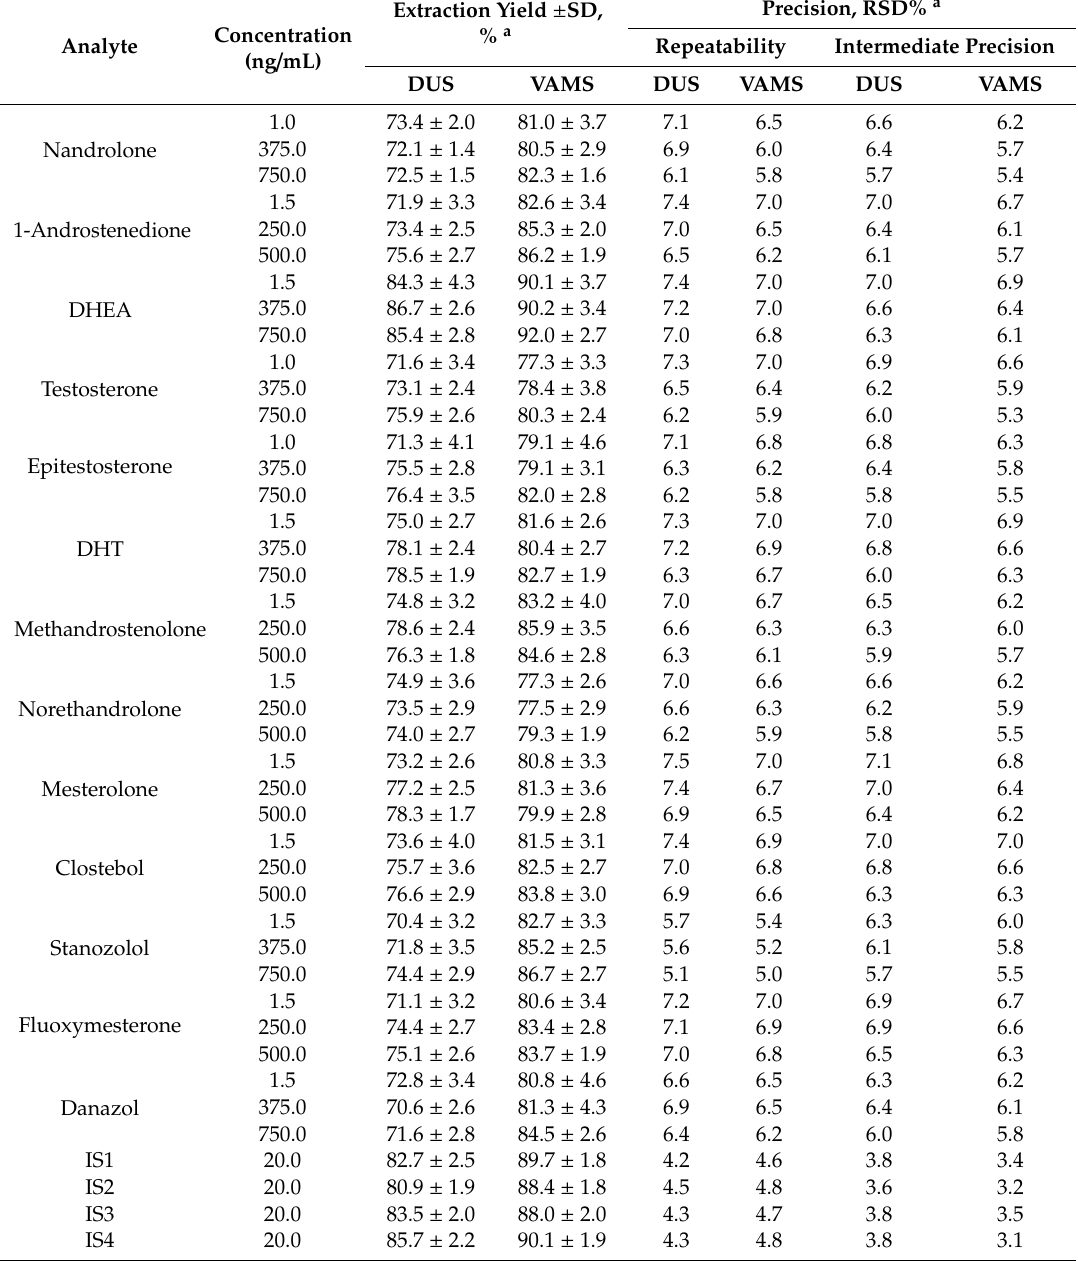
Table 5. Extraction yield and